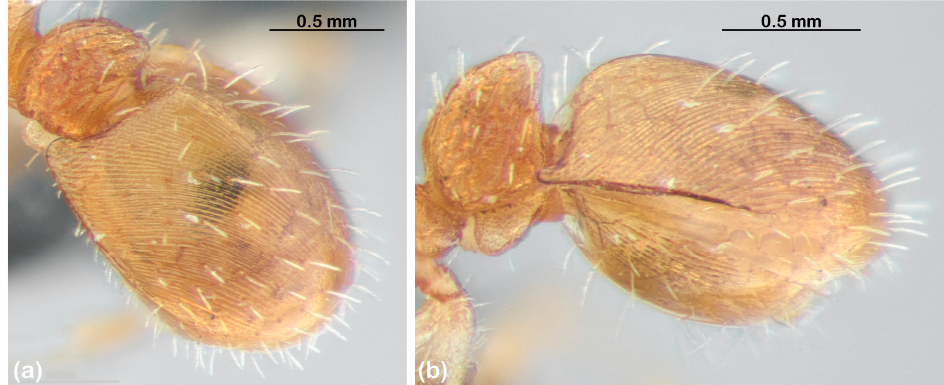
Figure 4. Ridged gaster. ( a ) Oblique view, showing dorsal ridge. ( b ) Lateral view, showing perpen- 4 dicular anterior face. Both images are of sp. 12; King River, NT (not sequenced).